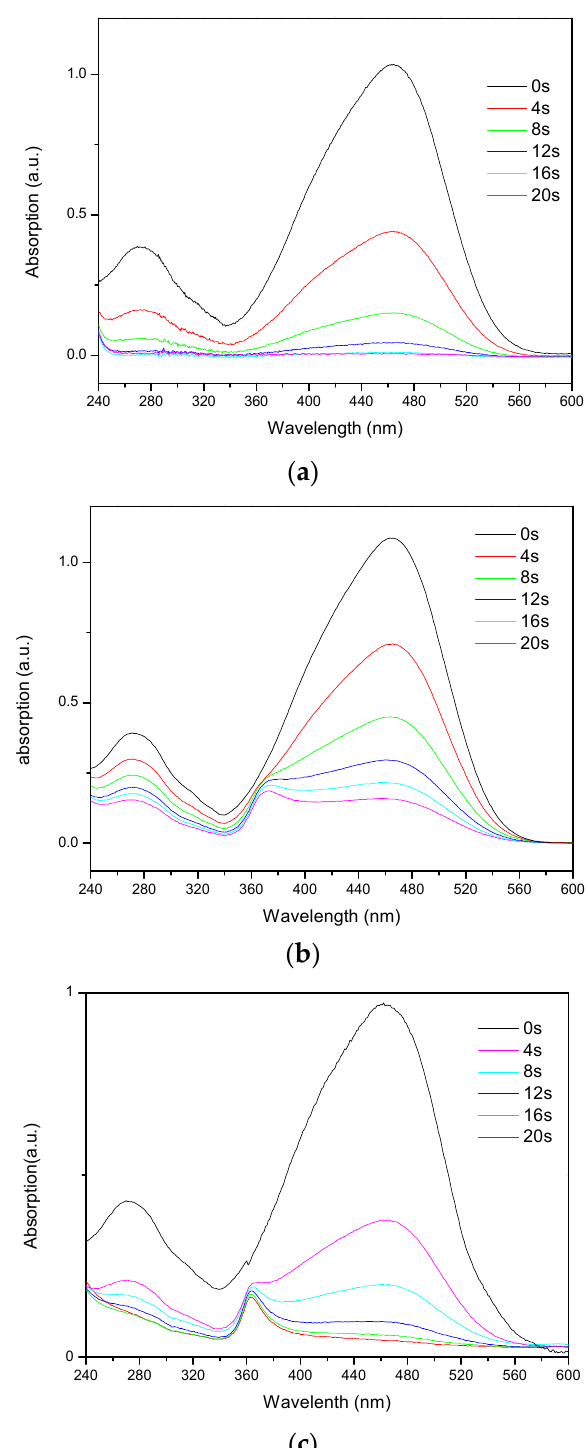
Figure 4. The optical absorption of methyl orange (MO) decolorized by adsorption using ZnO ( a ), Cu 2 O ( b ), and ZnO-Cu 2 O ( c ) as adsorbents. Cu 2 O ( b ), and ZnO-Cu 2 O ( c ) as